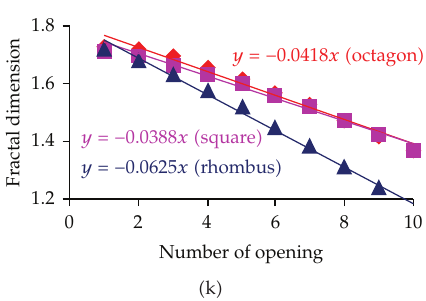
Figure 5: (cid:2) a–j (cid:3) Graphical plots between log (cid:2) number of pixels of pore connectivity network formed by